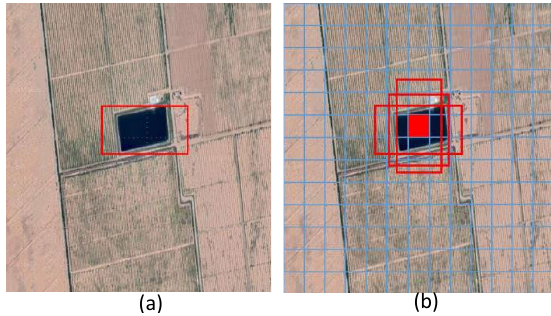
Figure 6. Schematic of the YOLOv3 prediction bounding box with 13 cells × 13 cells. (a) YOLOv3 detection process on 13 cells × 13 cells feature map; (b) YOLOv3 detection